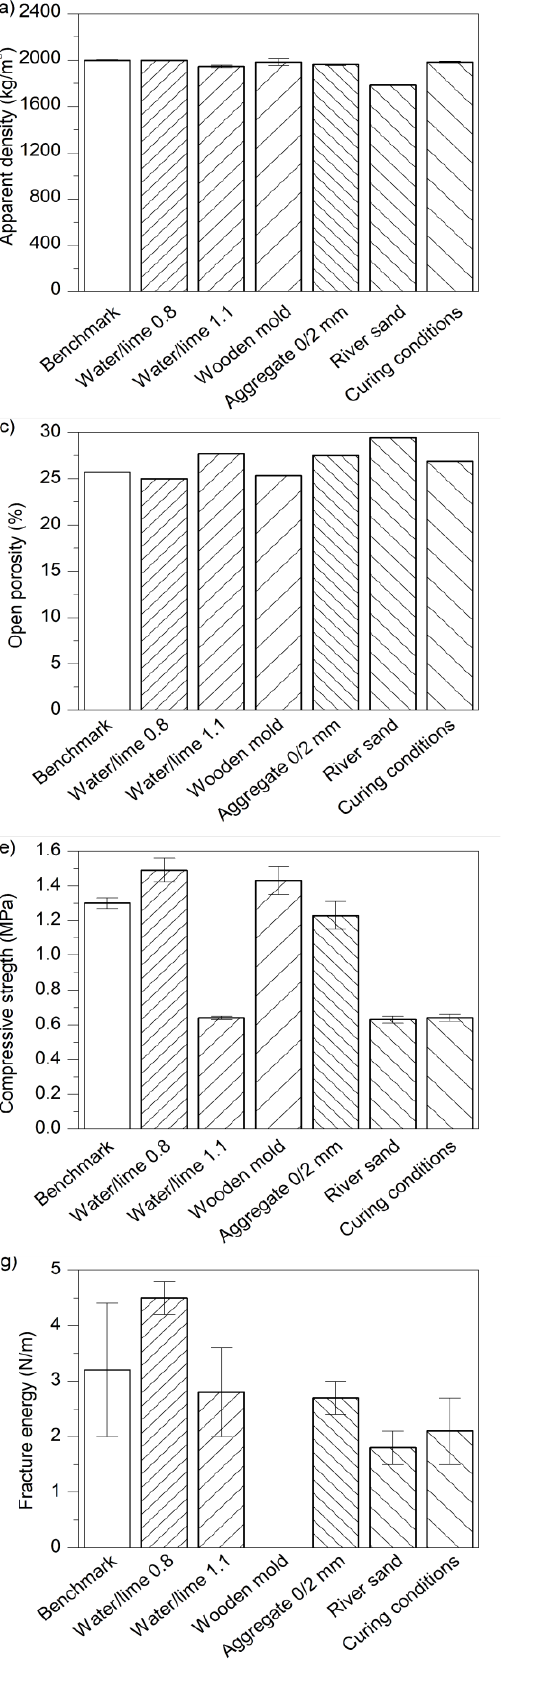
Figure 2. Properties of air lime mortars in a hardened state: (a) apparent density, (b) capillary water absorption coefficient, (c) open porosity, (d) flexural strength, (e) compressive strength, (f) splitting tensile strength, (g) fracture energy, and (h) elastic